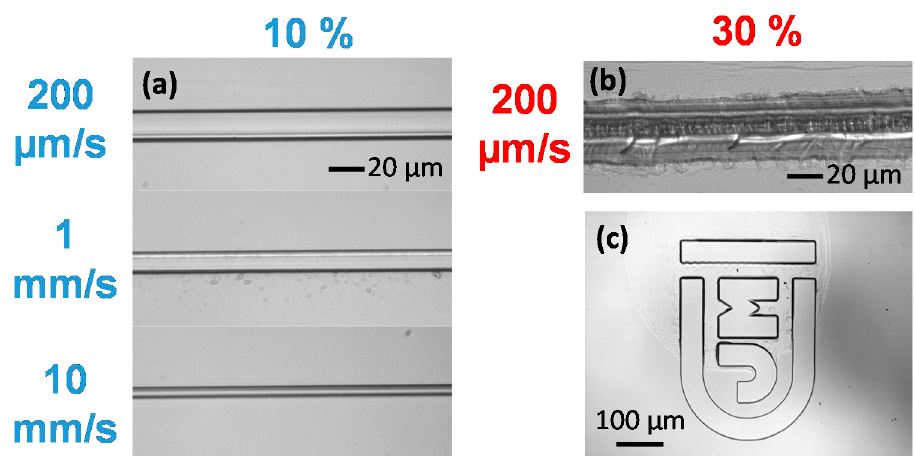
Figure 7. Structures obtained by the direct writing technique showing ( a ) lines obtained at 10% and for different scanning speed (200 µ m/s, 1 and 10 mm/s), ( b ) calcinated trace induced at 30% and 200 µ m/s and ( c ) Jean Monnet University logo with a 420 µ m size in